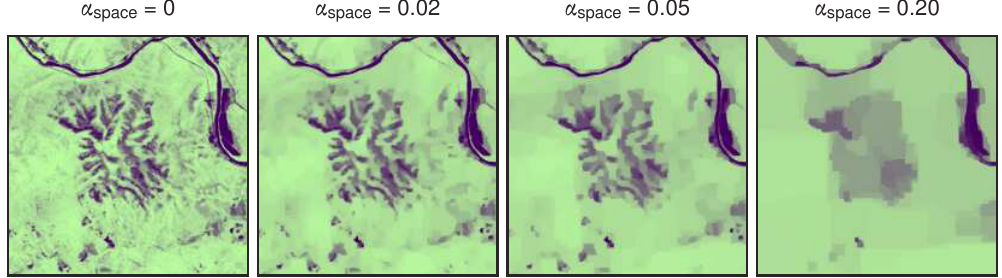
Figure 3. Two-dimential total variation regularization over a false color vegetation index near a wildfire. Low values of α space preserve more small-scale features while high values incorporate local heterogeneity into uniform